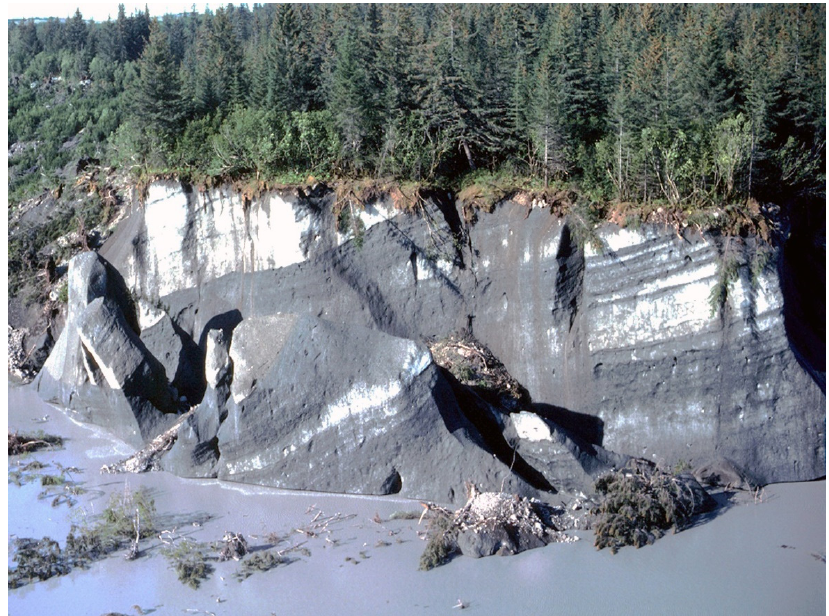
Figure 3. North-looking oblique aerial photograph of part of the vegetation-covered, stagnant ice terminus of Malaspina Glacier at Sitkagi Bluffs. The cliff of stagnant ice is approximately 15–20 m high, topped by a thin debris layer. A dense forest, composed of alders, willows, and conifers is rooted in this glacial sediment layer. As the ice melts, the trees topple into the lagoon. Maximum tree height is >15 m. The banding on the ice surface is composed of a thin drape of sediment deposited by meltwater (photo: B. F. Molnia in the 1980s). One of the earlier accounts on plant growth on DCGs employing systematic vegeta- tion sampling was our paper titled “Did debris-covered glaciers serve as Pleistocene refu- gia for plants? A new hypothesis derived from observations of recent plant growth on glacier surfaces”, published in Arctic, Antarctic and Alpine Research in 2007 [45]. This publication was pioneering at the time it was published, as it included both phytosocio- logical sampling on the debris mantled glacier surface of Carbon Glacier on Mount Rainier (Washington, DC, USA), together with short-term microclimatic measurements and de- termination of debris thickness and particle size spectra to allow for a rough ecological interpretation of the vegetation patterns found. In addition, the paper presented uncon-